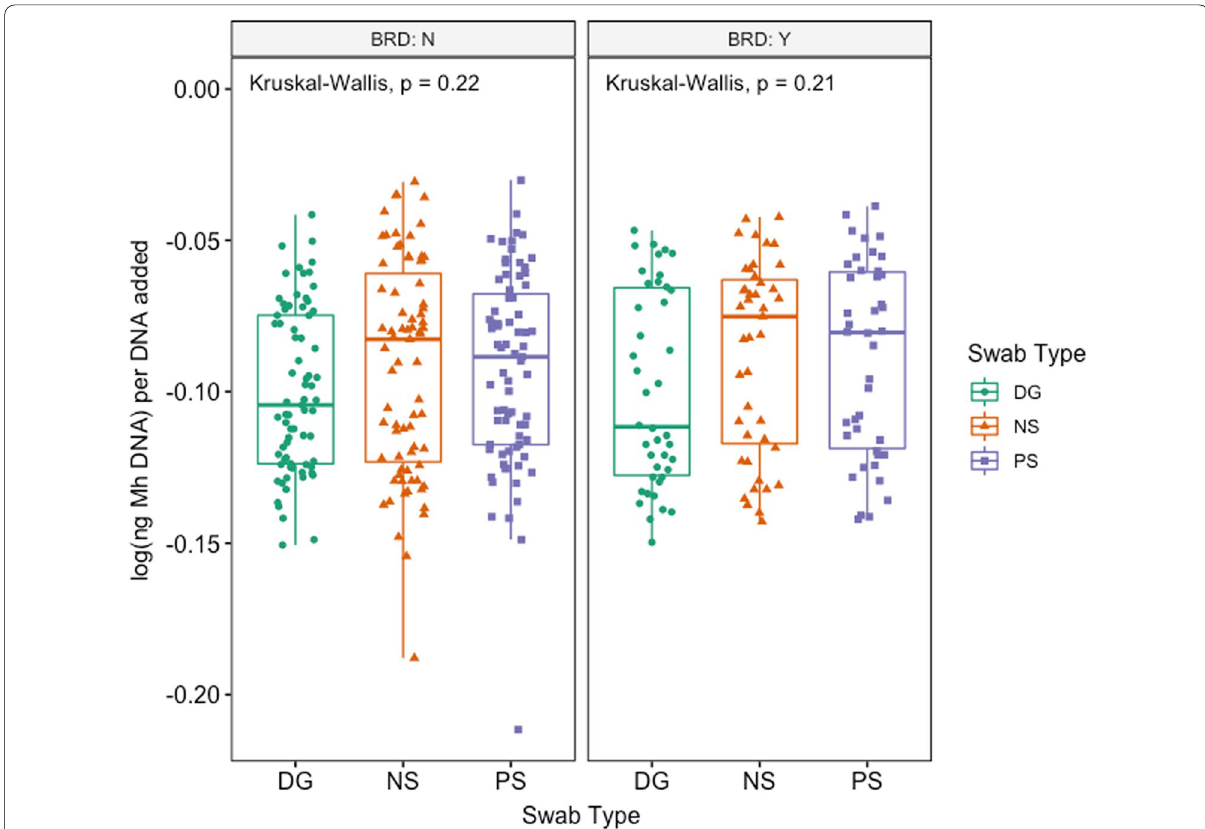
Fig. 3 Box and whisker of log(ng Mh DNA) per ng DNA added vs. swab type, separated by BRD treatment (Kruskal–Wallis test, P > 0.05). Key: DG double guarded swab, NS =